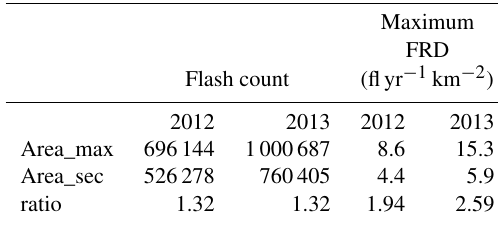
Table 1. Flash count and flash density in both